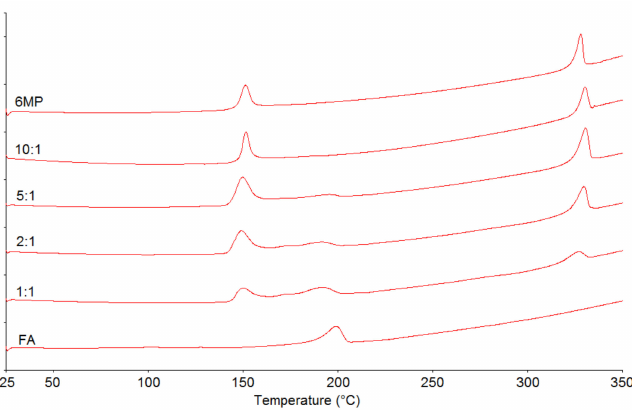
Figure 2. Differential scanning calorimetry (DSC) thermograms of 6MP, FA and their physical blends. Numbers denote 6MP:FA mass ratios in the